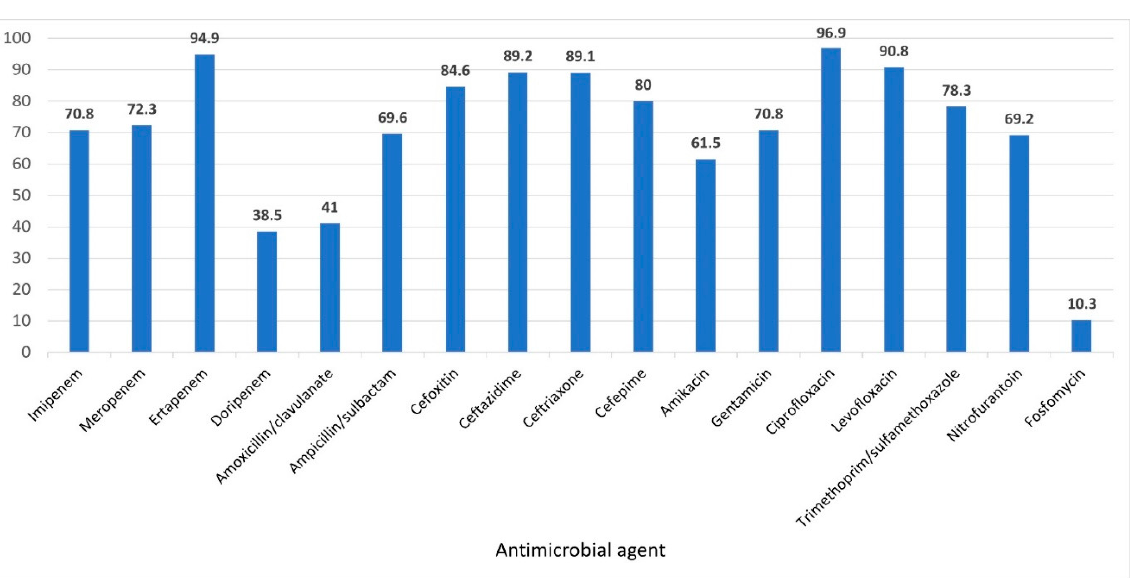
Figure 1. Prevalence of antimicrobial resistance of 65 carbapenem-resistant Gram-negative bacterial uropathogens to various tested antimicrobial agents. Prevalence was expressed as percent of resistant isolates relative to the total tested bacterial species for each antimicrobial agent. Table 3. Resistance patterns to various antimicrobial agents among different tested carbapenem-resistant Gram-negative bacterial isolates ( n = 65).